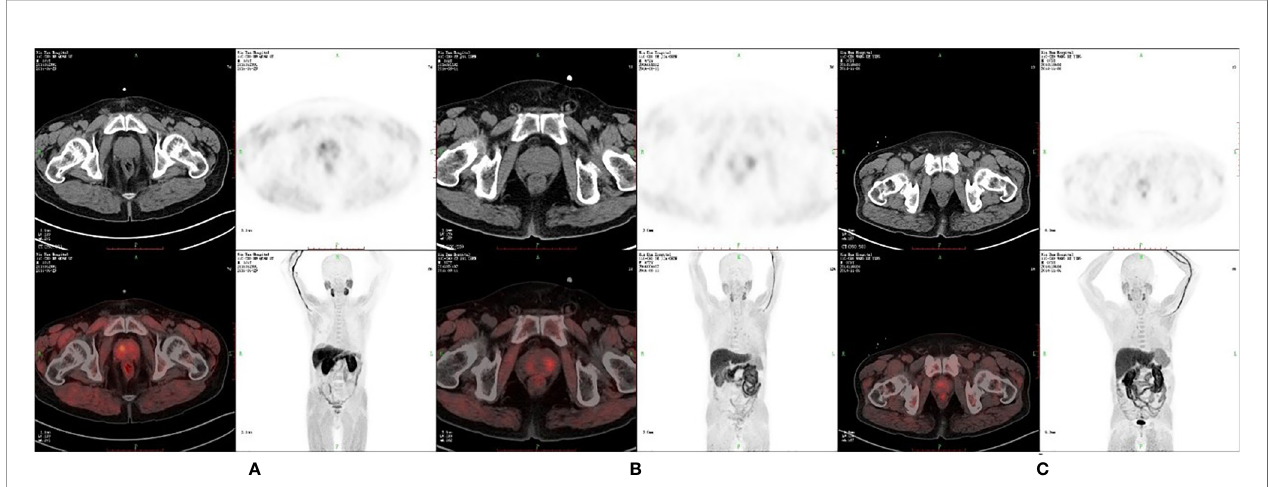
FIGURE 1 | 11 C-choline positron emission tomography (PET) image of patients with different prostate diseases. (A) SUVmax is 5.28, SUVmean is 3.24 and P/M ratio is 8.07 in patients with PCa. (B) SUVmax is 3.04, SUVmean is 2.64 and P/M ratio is 3.50 in patients with benign prostate hyperplasia (BPH). (C) SUVmax is 2.36, SUVmean is 1.67 and P/M ratio is 2.49 in patients with chronic protatitis